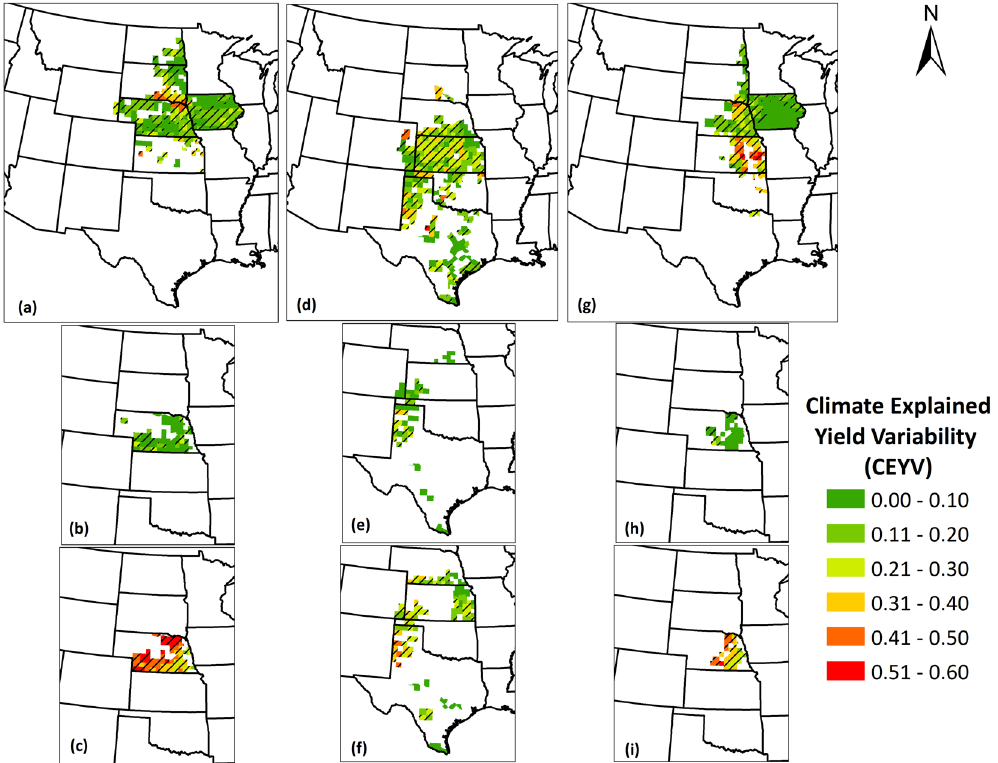
Figure 5. Climate explained crop yield variability (CEYV) for in ( a ) Maize; ( b ) Irrigated maize; ( c ) Non- irrigated maize; ( d ) Sorghum; ( e ) Irrigated sorghum; ( f ) Non-irrigated sorghum; ( g ) Soybean; ( h ) Irrigated soybean; ( i ) Non-irrigated soybean yields in the Great Plains counties over the period 1968–2013. The values range from 0 to 1. A value of 1 implies that complete variability in crop yields was explained by climate variability and likewise a value of 0.2 implies that 20% of the variability in crop yields was explained by climate variability. Counties with striped lines indicate that at least one climate factor significantly explained crop yield variability in that county at 95% confidence level. Regions with no data indicate that the crop yield dataset for a particular county was not complete. We created the maps using ESRI ArcMap 10.4.1 software http://desktop.